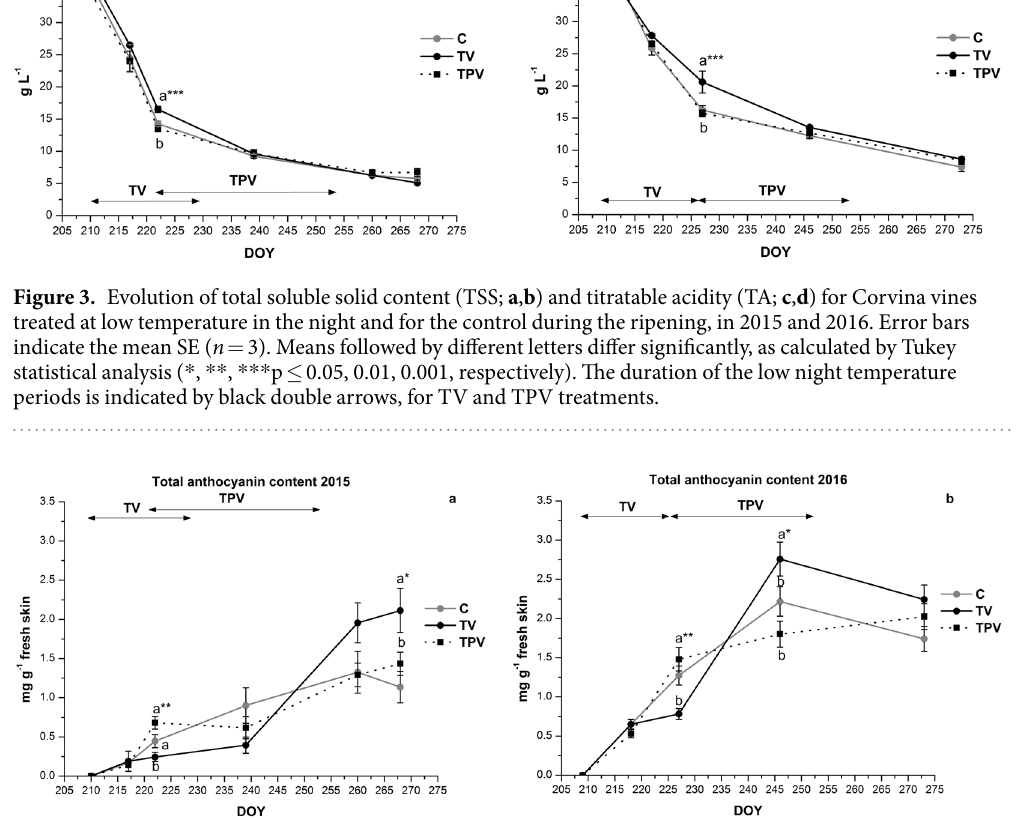
Figure 4. Trends of total anthocyanin concentrations in the skin of Corvina grapes treated under low night temperature (TV, TPV) and in the control (C), during the experimental period in 2015 ( a ) and 2016 ( b ). Error bars indicate the mean SE ( n = 3). Means followed by different letters differ significantly, as calculated by Tukey statistical analysis ( * , ** p ≤ 0.05, 0.01, respectively). The duration of the low night temperature periods is indicated by black double arrows, for TP and TPV